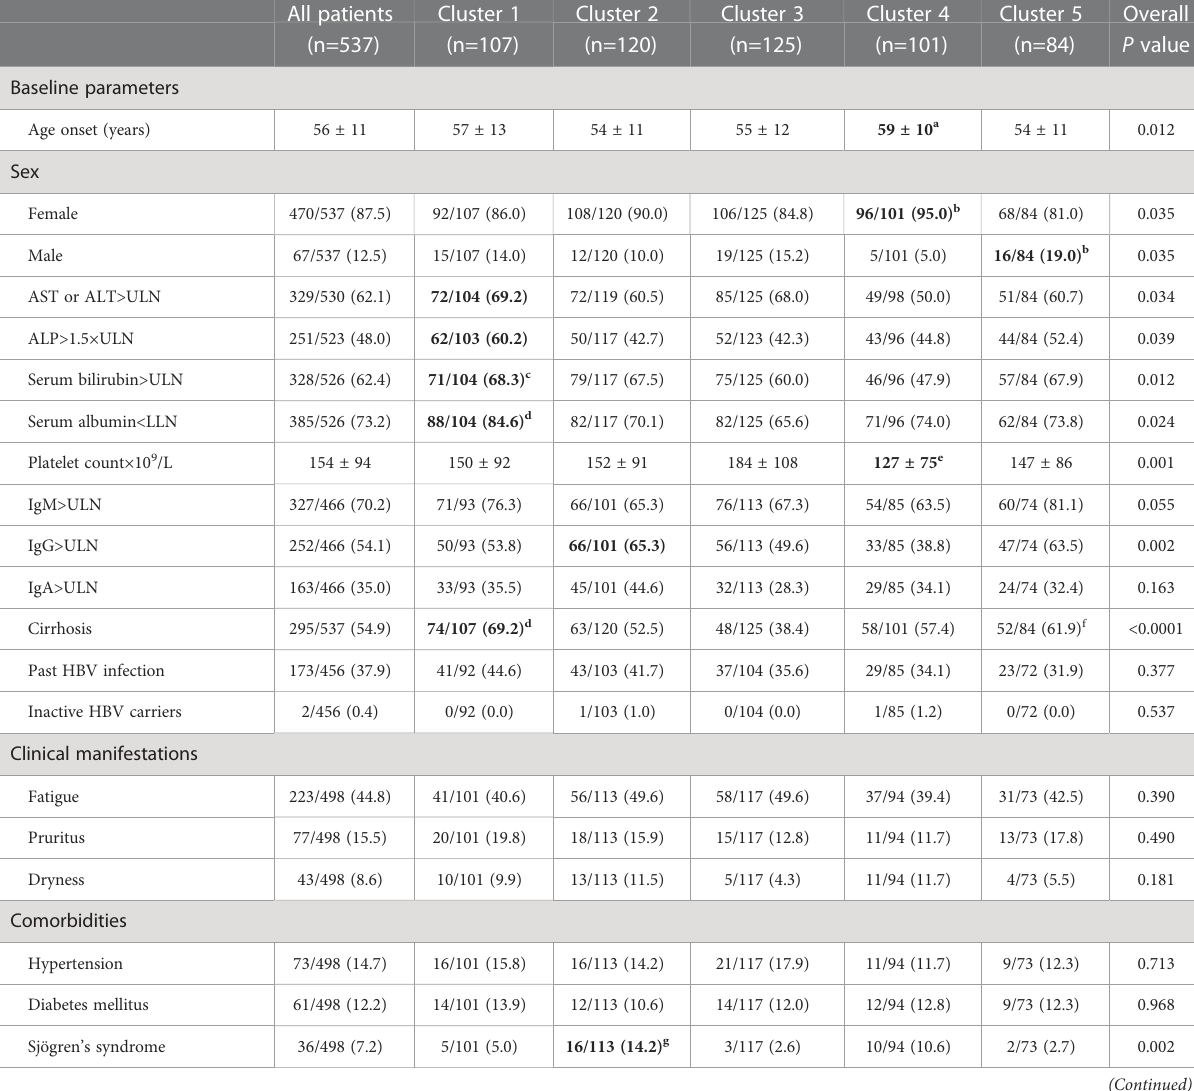
TABLE 2 Baseline parameters and clinical outcomes of patients with PBC among autoantibody